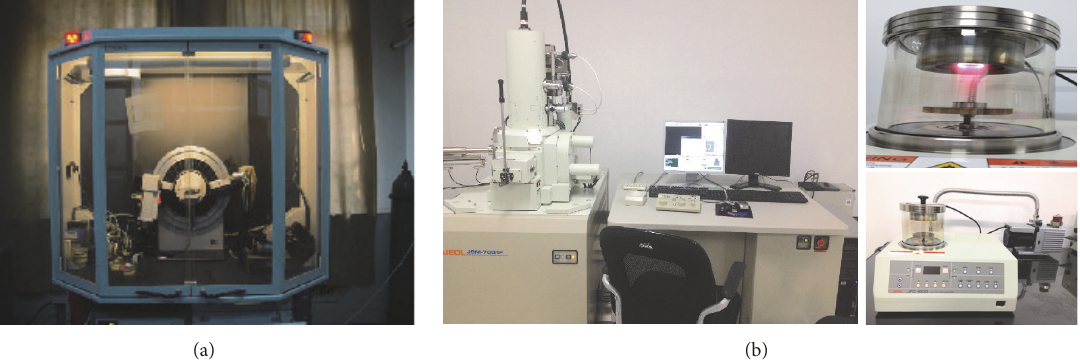
Figure 1: D8 Advance X-ray diffractometer (a) and JSM-7001F Field Emission Transmission Electron Microscopy (b).